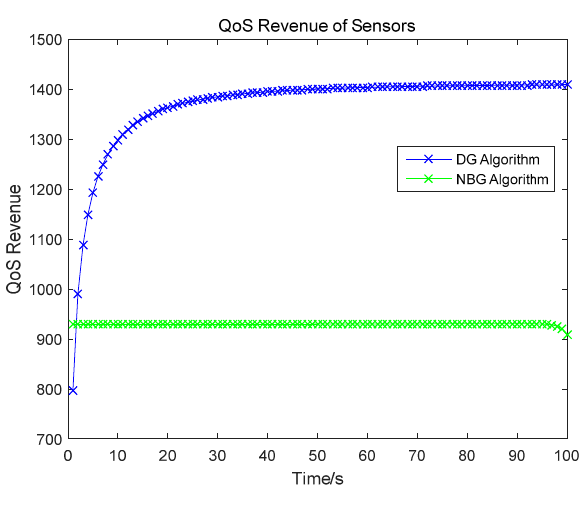
Figure 10. QoS revenue of sensors.